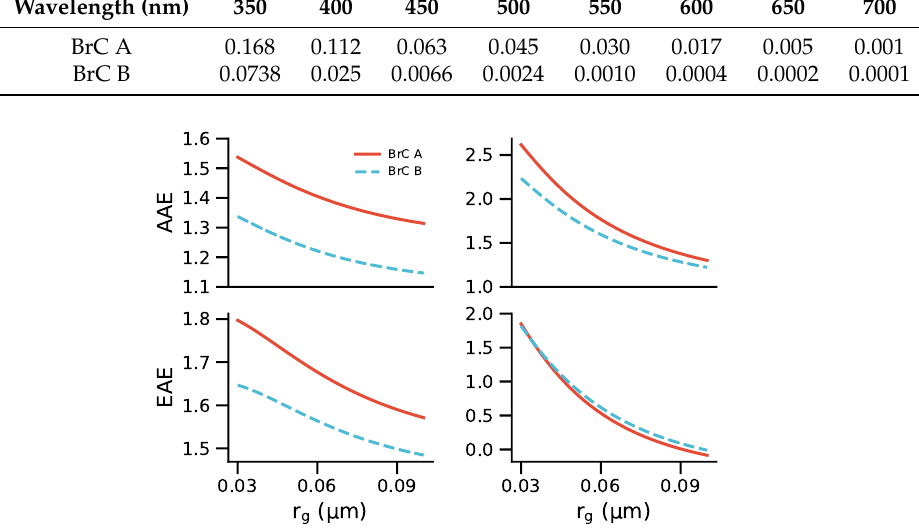
Figure 10. The sensitivity of AAE (350, 700 nm) and EAE to the imaginary part of BrC coatings RI, BrC A and BrC B represent the measured values by Kirchstetter et al. [83] and Chen and Bond [84]. The figures in the left column represent AAE and EAE of thinly-coated BC, and the right column represent AAE and EAE of heavily-coated BC. BC/OC = 0.1 for thinly-coated BC and BC/OC = 0.096 for heavily-coated BC.